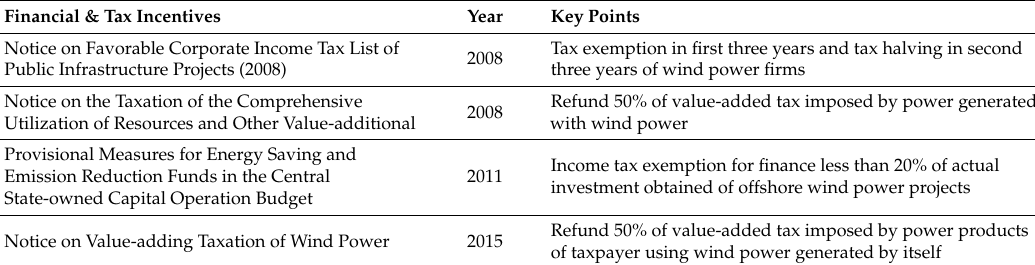
Table 4. Financial & tax incentives of wind power in